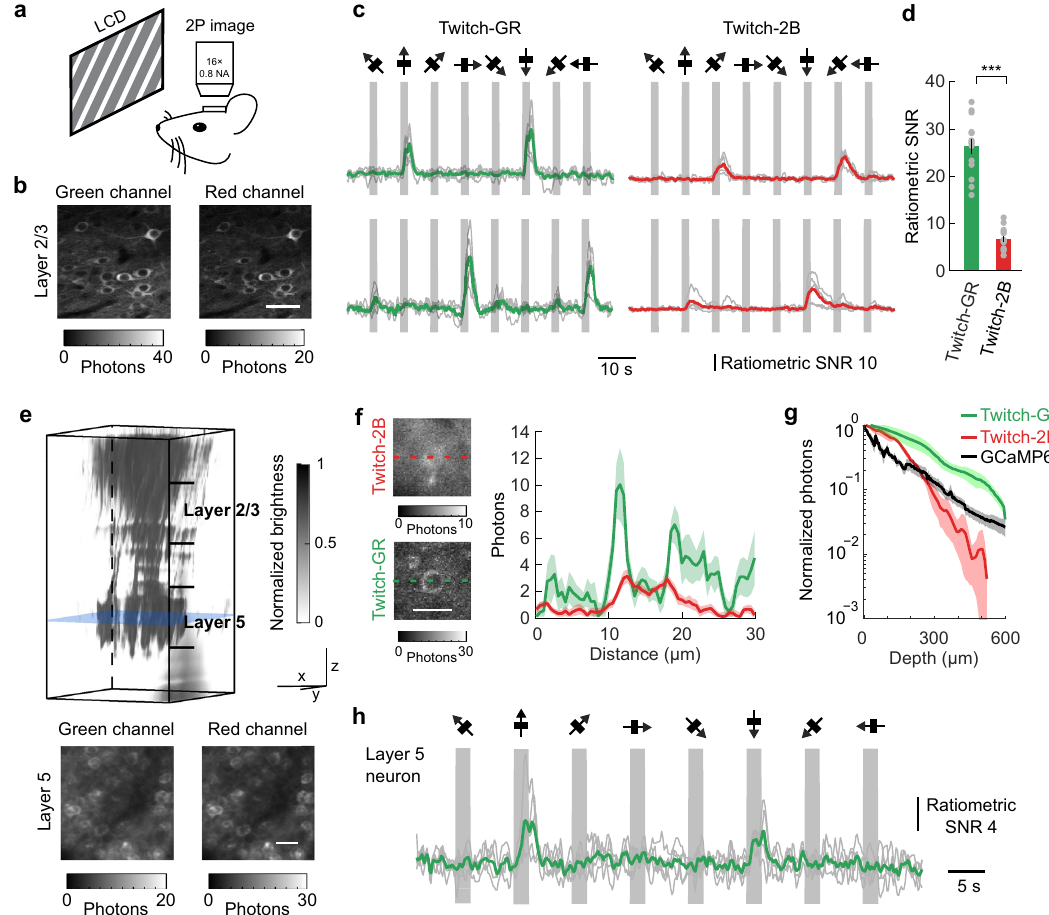
Fig. 4 Twitch-GR reported cellular visual response pro fi les in mice during awake behavior. a The schematic shows the experimental setup for the delivery of drifting grating visual stimuli and simultaneous two-photon imaging. b Two-photon images from in layer 2/3 neurons expressing the Twitch-GR sensor, separated into the green ( left ) and red ( right ) fl uorescence channels. The scale bar is 20 µ m. c Ratiometric traces of representative layer 2/3 neurons expressing Twitch-GR ( left ) and Twitch-2B ( right ) displayed orientation-selective response to a set of eight different orientations of drifting grating stimuli. d The peak ratiometric SNR of Twitch-GR was signi fi cantly higher than the response of Twitch-2B (two-sided Wilcoxon rank-sum test, n = 10 neurons for each sensor, error bars are s.e.m.; *** signi fi es p < 0.001). Gray dots indicate individual data points. e Three-dimensional stacks imaged from the brain surface down to 600 μ m depth. The z stack ( top ) showed the entire cortical structure, while the green and red channel images at 500 μ m indicated by the blue slice of the stack ( bottom ) showed individual neurons. The three-dimensional scale bars for the top panel are 100 μ m along each of the three axes, while the scale bar for the bottom panels is 30 µ m. f Left : Total fl uorescence images of a representative neuron expressing Twitch-2B or Twitch-GR at a depth of ~350 µ m. Each image was the average of 10 imaging frames. Right : Pro fi les along the dashed lines demonstrated cytoplasmic localization for Twitch-GR, but not for Twitch-2B (shaded regions are s.e.m., n = 10 frames). The intensity pro fi les removed the background fl uorescence. The scale bar is 15 µ m. g The average number of photons normalized for excitation power obtained over the whole fi eld-of-view as a function of the imaging depth (error bars are s.e.m., n = 3 stacks imaging from 2 – 3 mice for each sensor). ( h ) Ratiometric responses of a layer 5 neuron expressing Twitch-GR displayed orientation-selective response to eight different orientations of drifting grating